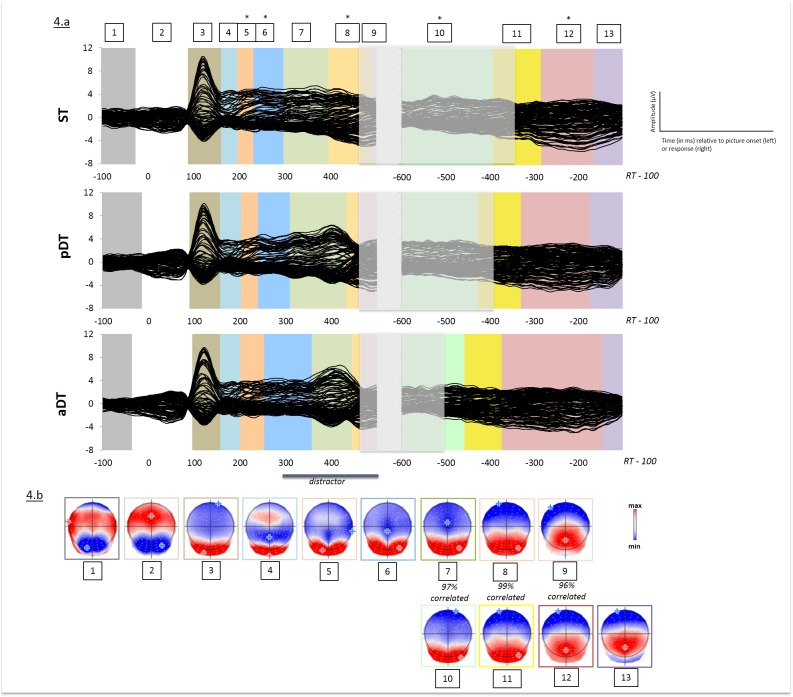
(a) Grand-average ERPs (128 electrodes) for each task (Single-task ST, passive dual-task pDT and active dual-task aDT) when distractors were syllables from 100 ms prior to picture onset to 100 ms before the verbal response and temporal distribution of the topographic patterns revealed by the spatio-temporal segmentation analysis. Stable electrophysiological configurations are color-coded. The white shaded area illustrates overlap between stimulus-aligned and response-aligned data as a function of grand-averaged production latencies for each task. (b) Map templates for the nine stable topographies observed from 100 ms prior to picture onset to RT-100. Positive (red) and negative (blue) values are displayed as well as maximal and minimal scalp field potentials. Correlations between map templates 7, 8, 9 and 10, 11 and 12 respectively are indicated. * indicate significant differences (p < 0.05) observed on any specific topographic pattern contrasting ST, pDT and aDT.